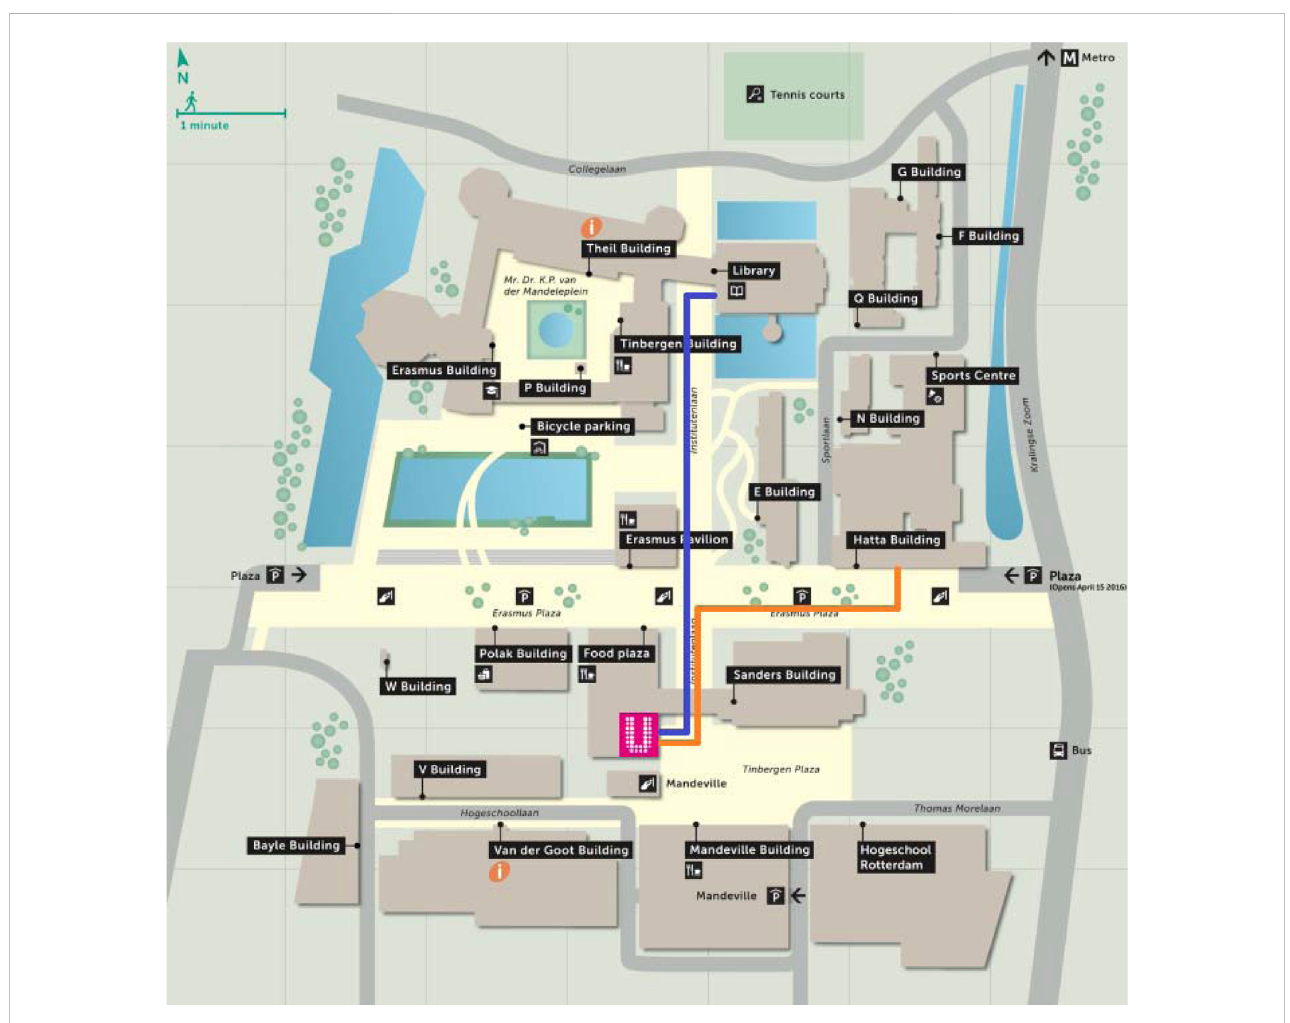
FIGURE 3 Routes of the delivery robot at EUR campus (blue: SPAR - Library: SPAR - orange Hatta).